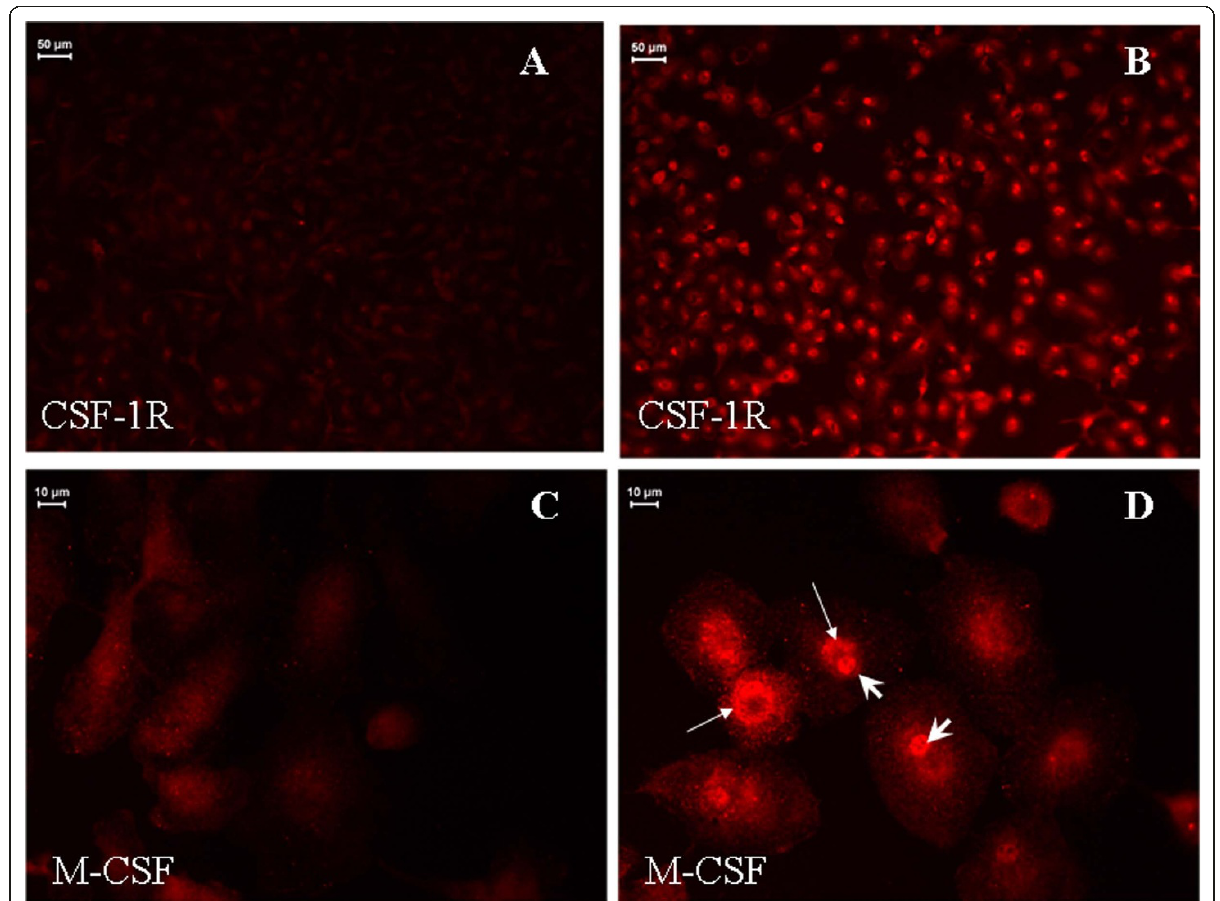
Figure 8 Effect of glycated albumin (GA) on microglial CSF-1R and M-CSF expression . (A) Without GA exposure, microglial cells exhibited weak CSF-1R immunofluorescence in the cytoplasm. (B) Following exposure to 250 μ g/mL GA for 24 h, the expression of CSF-1R was clearly up- regulated. (C) Similarly, weak M-CSF immunofluorescence was observed in the cytoplasm without GA treatment. (D) Following exposure to 250 μ g/mL GA for 24 h, the expression of M-CSF was up-regulated; the signal was detected in both the cytoplasm (long arrow) and nucleus (short arrow) of each